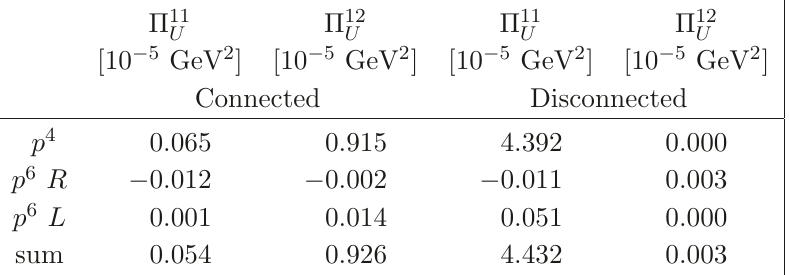
for the connected and dis- U